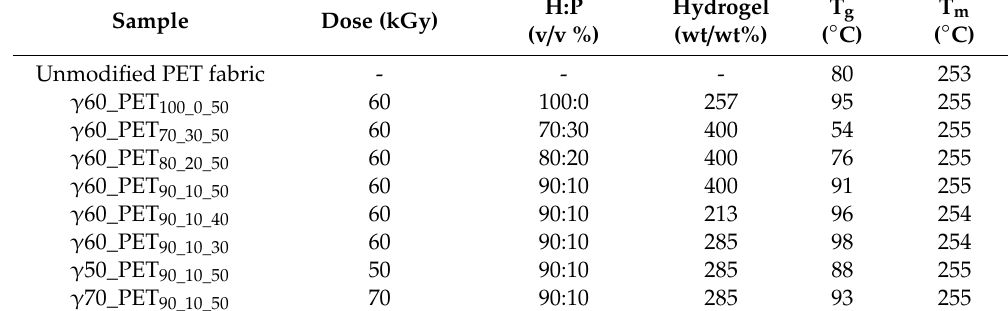
Table 3. Results by DSC for PET fabrics modified with hydrogel, obtained by the photochemical method. Figure 4. Differential scanning calorimetry (DSC) curves of ( a ) PET, ( b ) UV PET 95:5:0.25 96% hydrogel, and ( c ) UV PHEMA hydrogel.